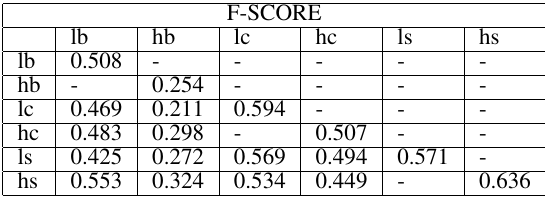
Table 9. F-score values in when using altered images